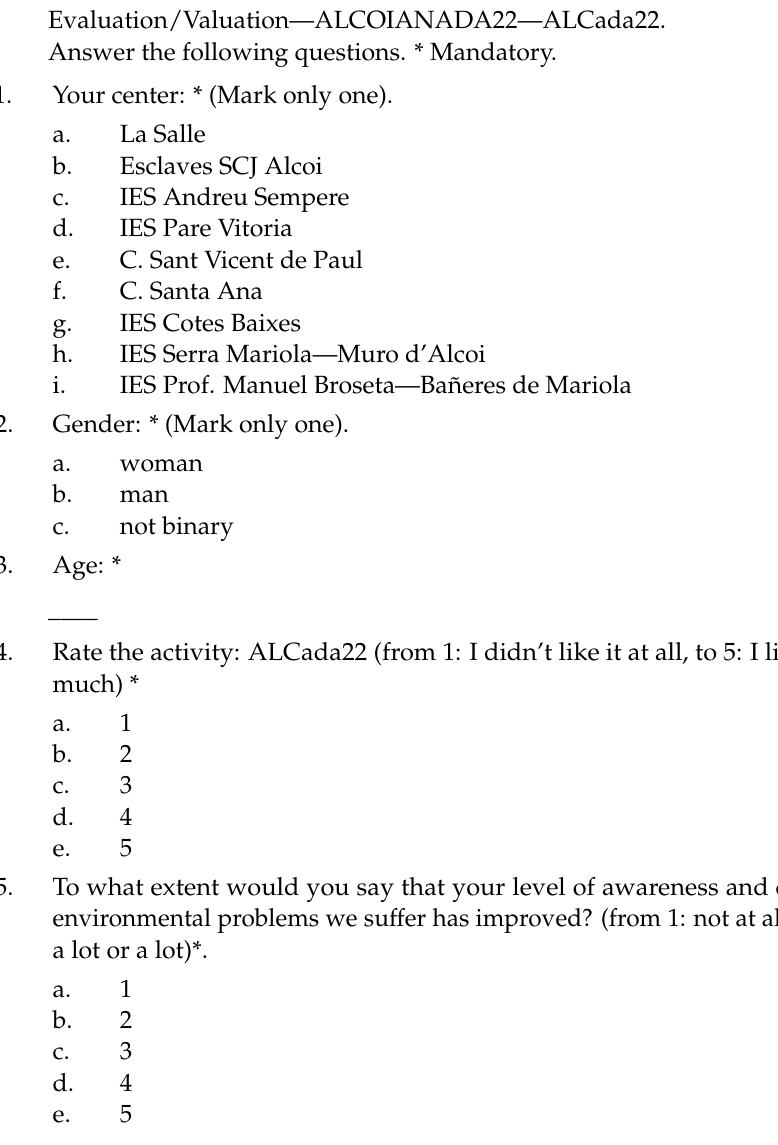
Figure A4. Example 2 of the test with the app: PlantNet. Notes: Trifolium repens L. White clover.